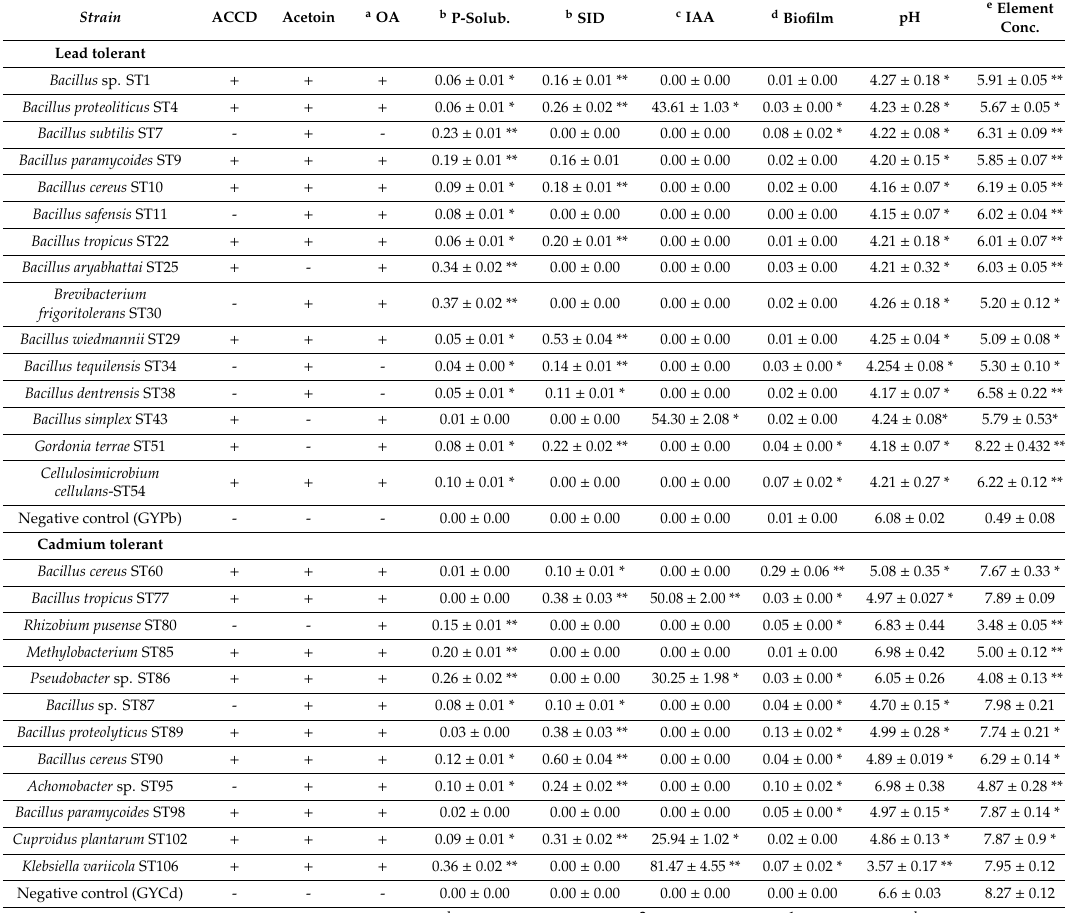
Table 2. Plant growth-promoting properties of trace element-tolerant bacteria.